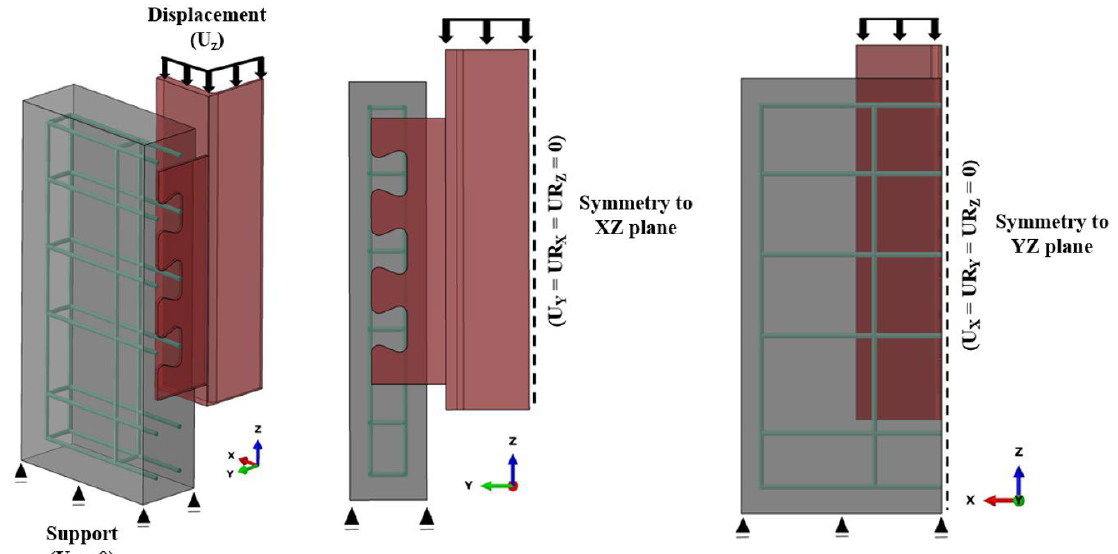
Figure 7. Geometry and boundary conditions of the numerical model (group D2).